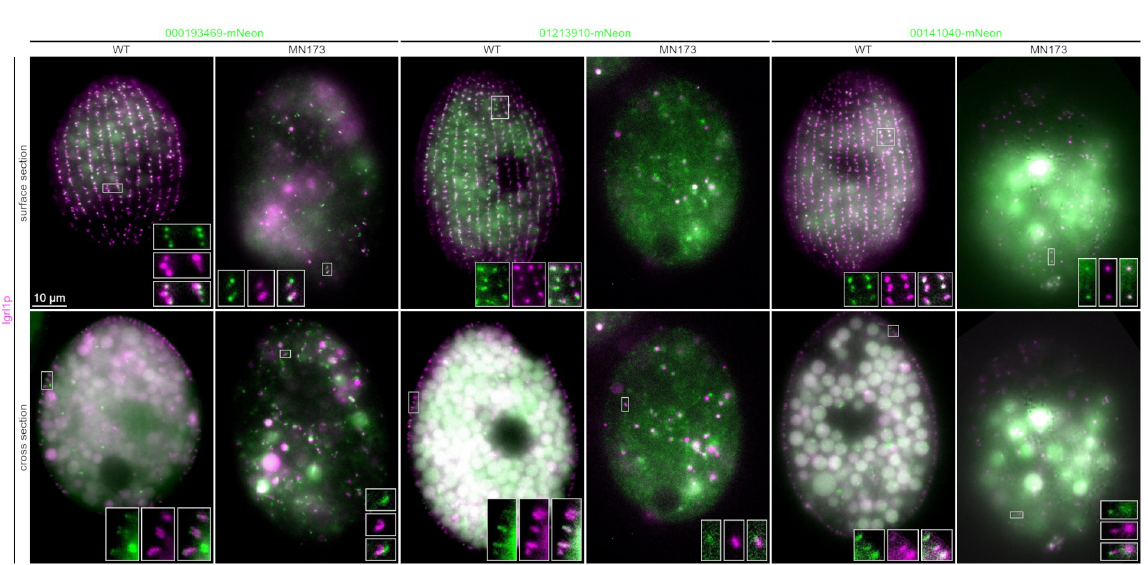
Fig 7. Colocalization of MDD subunits and mucocysts. Surface and cross-sectional images of live wildtype or MN173 cells expressing putative MDD subunits endogenously tagged with mNeon (green) at their C-terminus. A mucocyst content protein, Igr1p, was endogenously tagged with mCherry (magenta). Inserts show enlarged and adjusted separate and merged channels for the boxed areas. Scale bar is